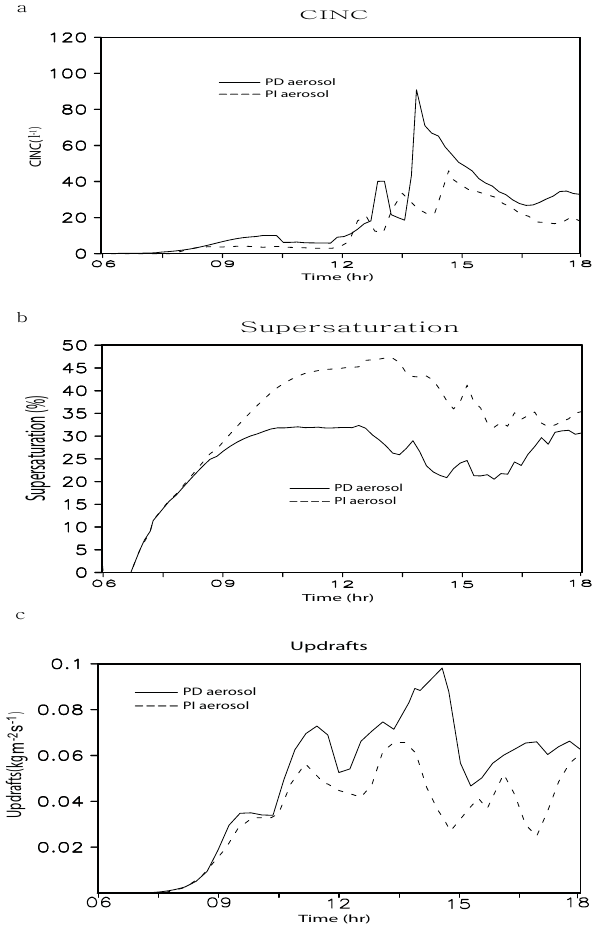
Fig. 6. Time series of conditionally averaged (a) CINC and (b) supersaturation over areas where deposition rate is positive and (c) the time series of the domain-averaged